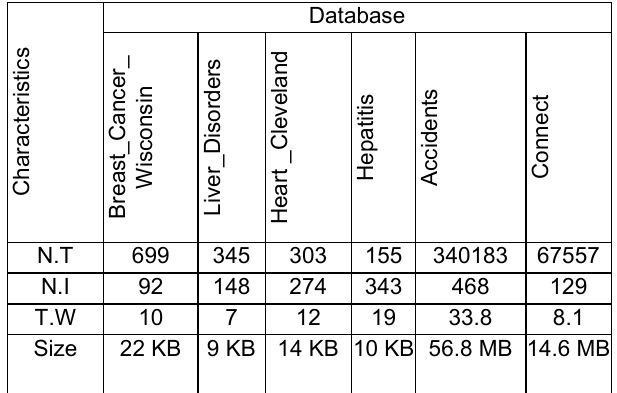
Table 1. Database Description (N.T: Number of Transactions, N.I: Number of Items, T.W: Transaction Width)